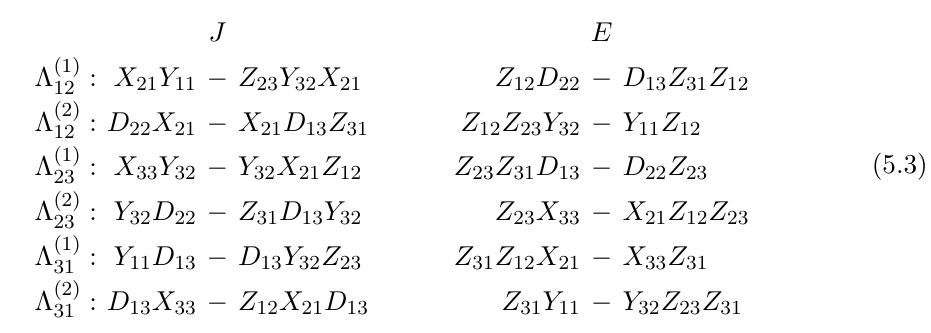
The J - and E -terms